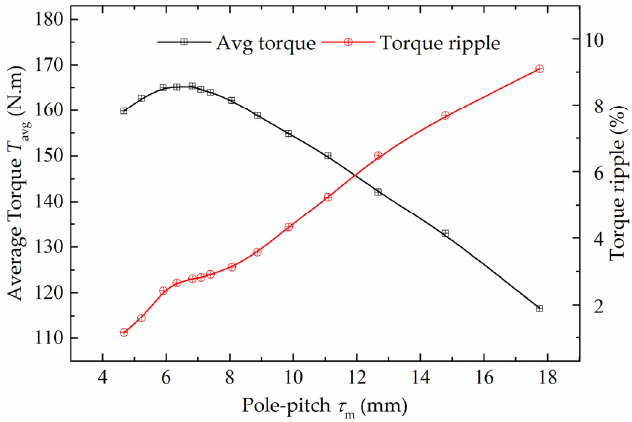
Figure 11. The influence of pole ‐ pitch τ m on average torque and torque ripple.